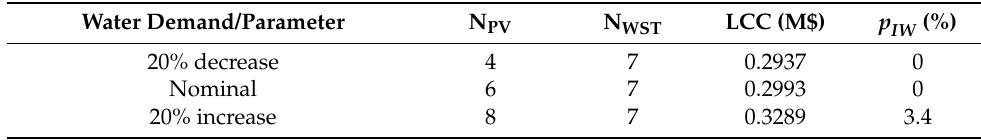
Table 15. Optimization results from water demand